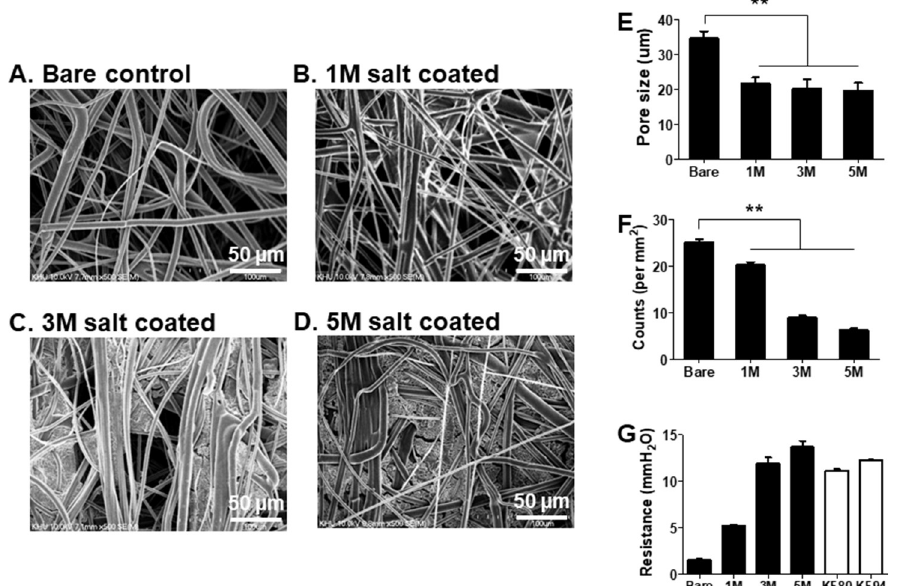
Fig 2. SEM images of filters coated with sodium dihydrogen phosphate. Surgical mask filters were coated with various concentrations of sodium dihydrogen phosphate and the pore size, pore count, and resistance (mmH 2 O) were assessed. A. non-coated bare filter control, B. Filter coated with 1M of coating solution, C: Filter coated with 3M of coating solution, D: Filter coated with 5M of coating solution. E. Pore size of filter ( �� P < 0.01), F. Pore counts of filters ( �� P < 0.01). G. Air resistance of filters were tested at non-coated bare control, 1M coated, 3M coated and 5M coated mask filters, of which corresponding filters are abbreviated as Bare, 1M, 3M and 5M, each respectively. KF80 and KF94 are abbreviations for mask filters which are commercially available in